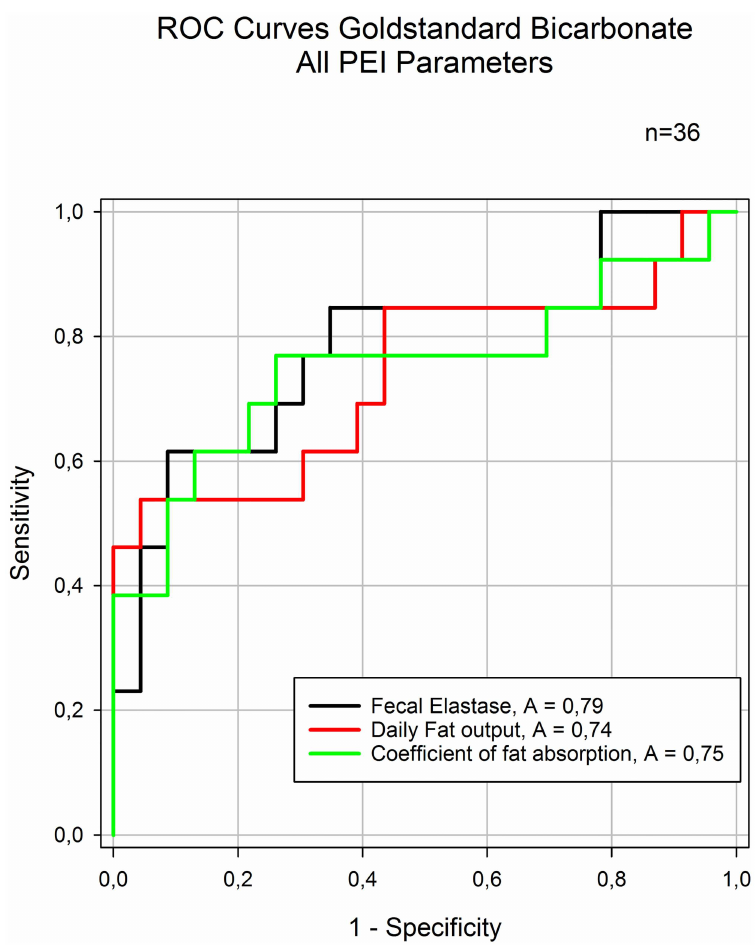
Fig 4. ROC curves for EPI parameters in all study subjects. As result of direct pancreas testing bicarbonate in duodenaljuice after secretin stimulationwas chosen as standard. No significantdifference in Area under the curve (AUC) betweenf-Elastase and fecal fat (CI -0,15 to 0,25); f-Elastase and CFA (CI -0,19 to 0,25); fecal fat and CFA (-0,11 to 0,08) ROC curve = receiveroperatingcharacteristic curve; AUC = Area under the curve; CI = confidenceinterval.